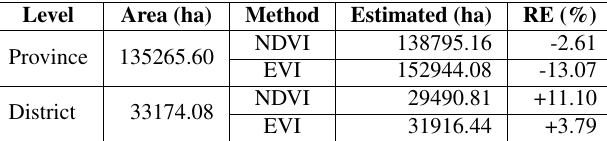
Table 4: Summary of the area based accuracy assessment